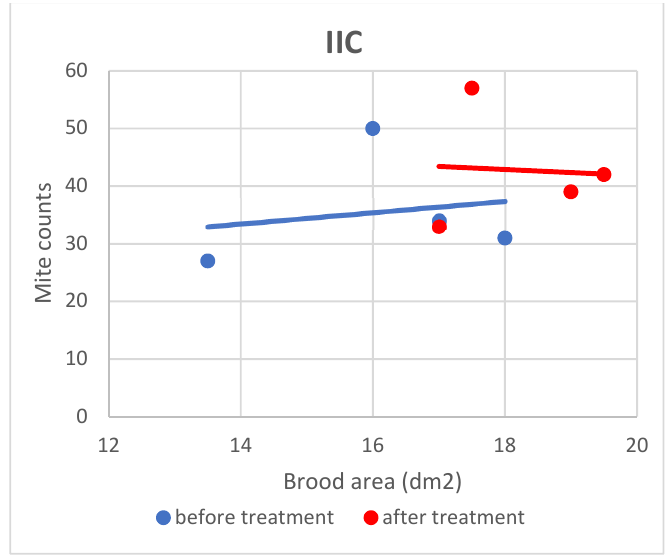
Figure 8. Linear regression plots of brood area (fixed factor) and mite counts in subgroup IIC before and after treatment.